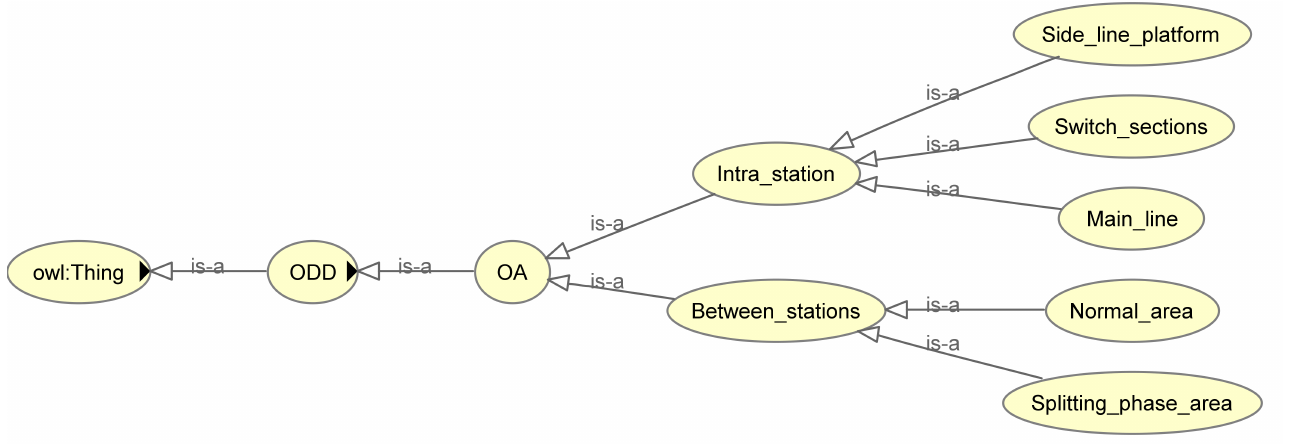
Figure 8. Structure diagram of the operating area.